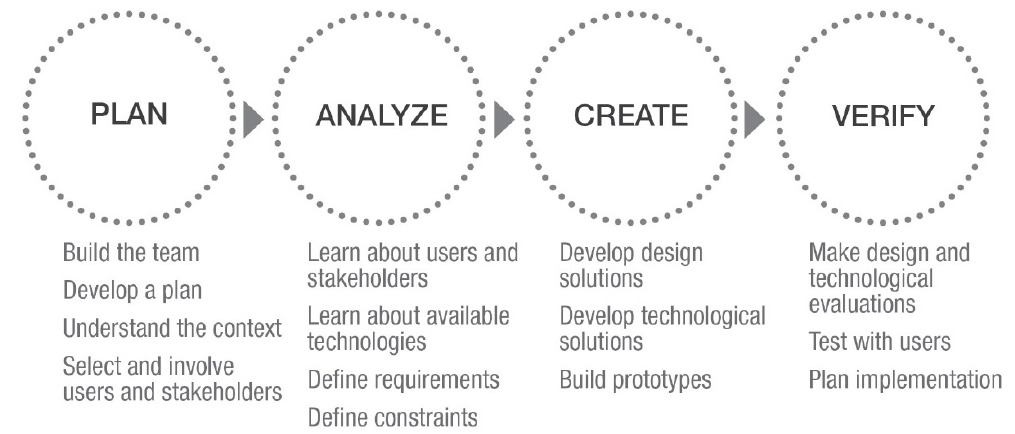
Figure 1. Scheme representing the design process proper of the user centered approach, as intended by usability.gov [29].